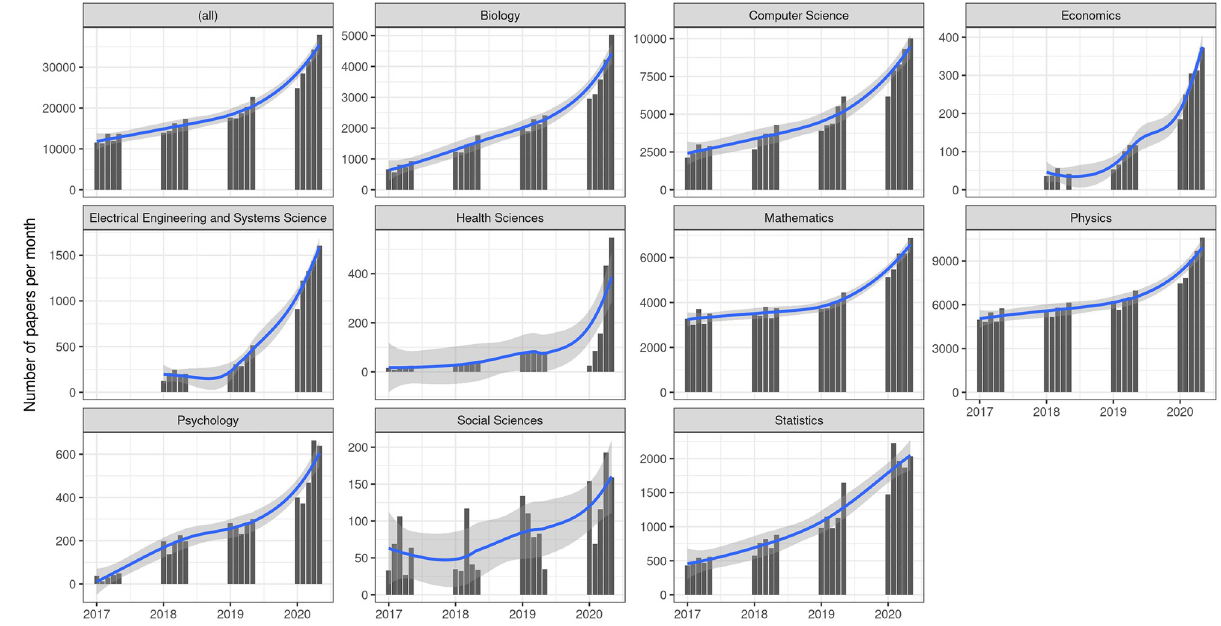
Fig 1. Number of submissions per month. The first facet ( all ) shows the global number of preprint submissions per month in all repositories during the period considered. Subsequent facets break down these numbers per category with varying scales for the vertical axis.